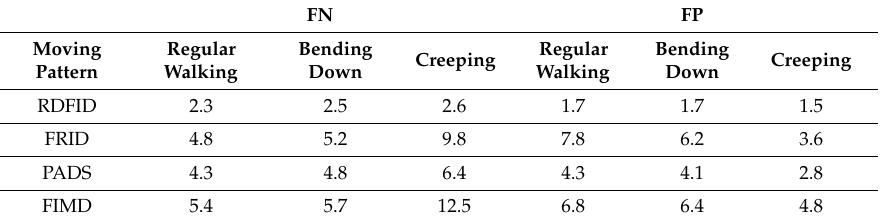
Table 5. FN/FP of human detection under different moving patterns (%).